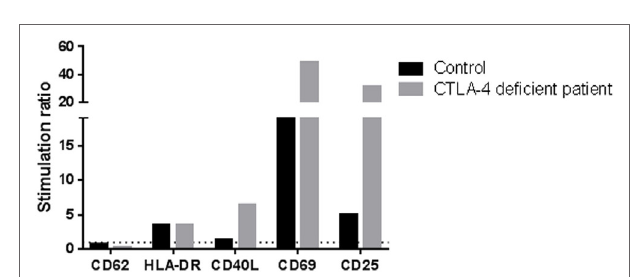
FigUre 2 | Stimulation ratio of different lymphocyte activation markers after PHA stimulation (7 days). Stimulation ratio: mean fluorescence intensity of PHA-stimulated/basal